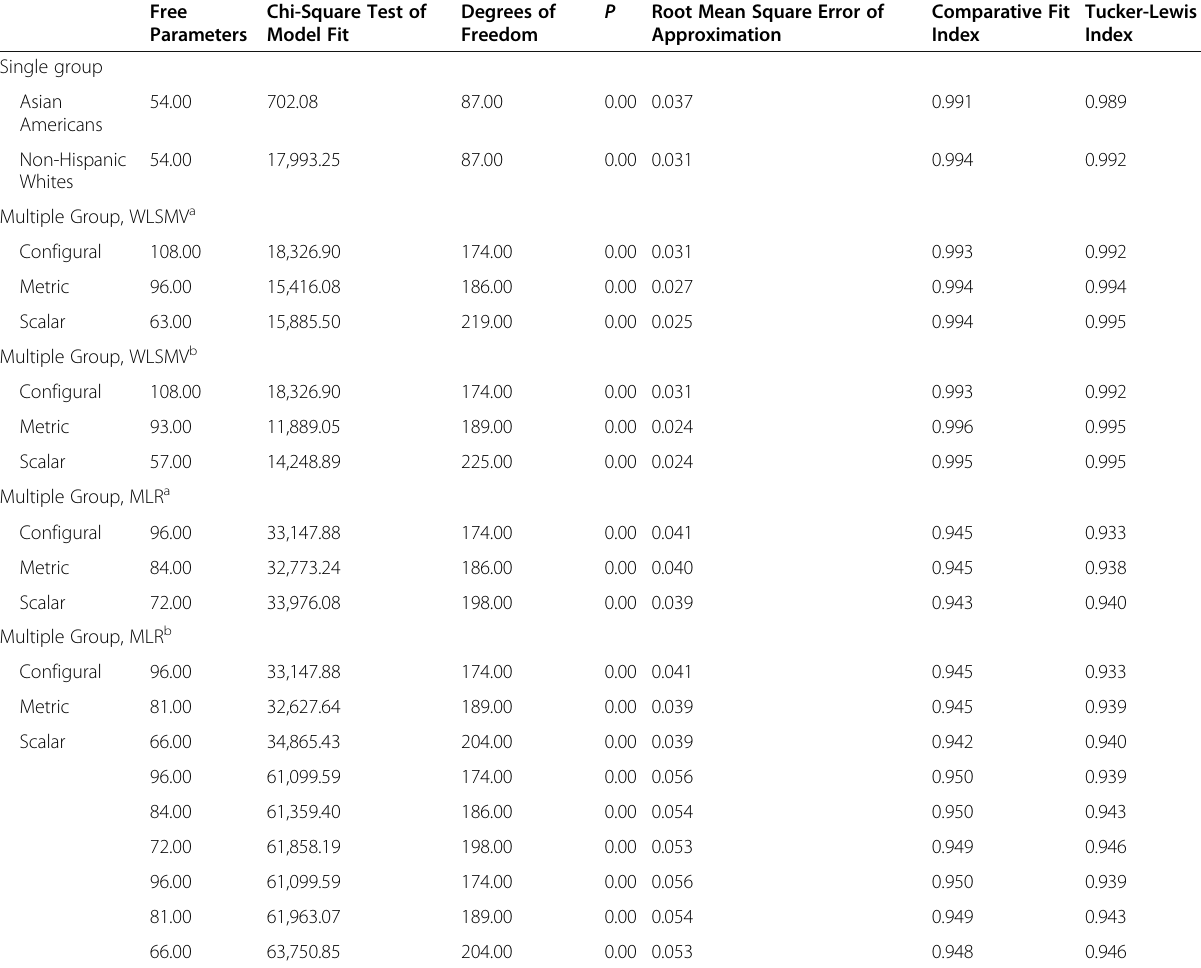
Table 5 Model fit indices for single group and multiple group confirmatory factor analytic models Free Chi-Square Test of Degrees of Parameters Model Fit